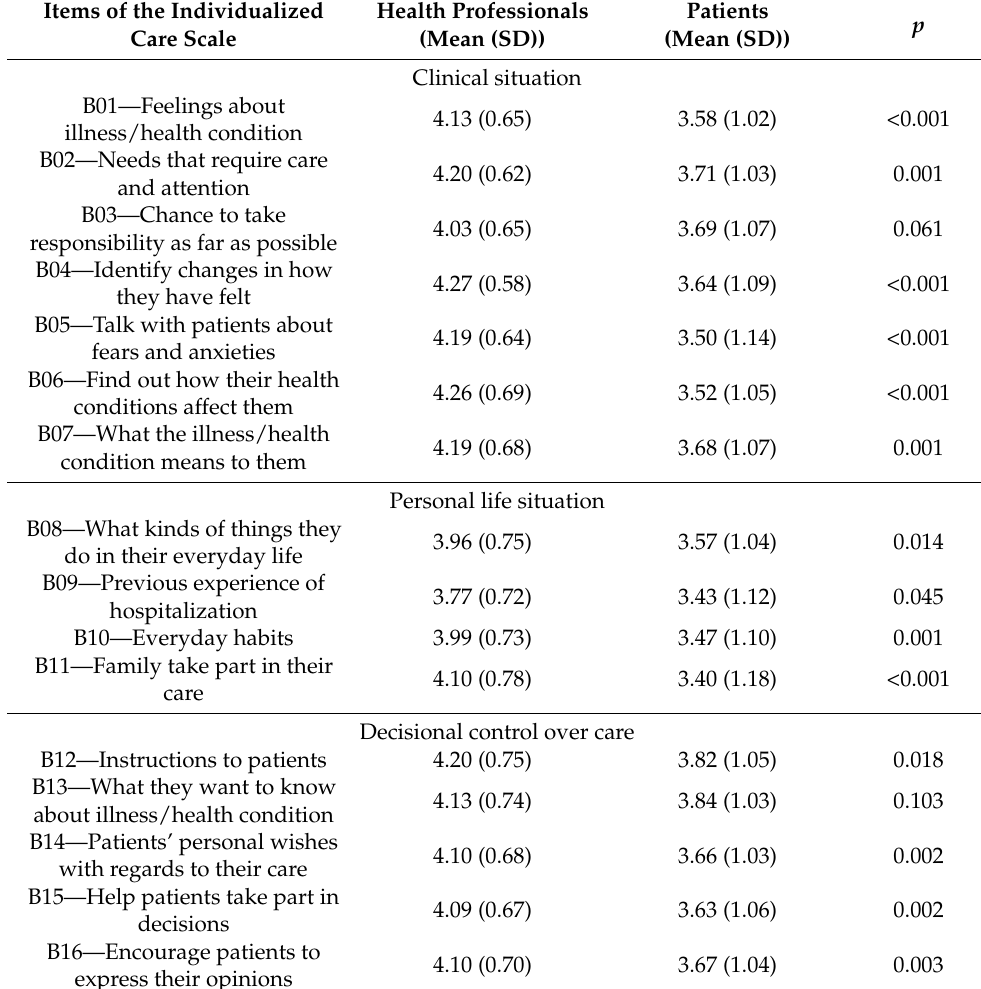
Table 5. Health professionals and patients’ assessments of the provision of individualized care: item-level